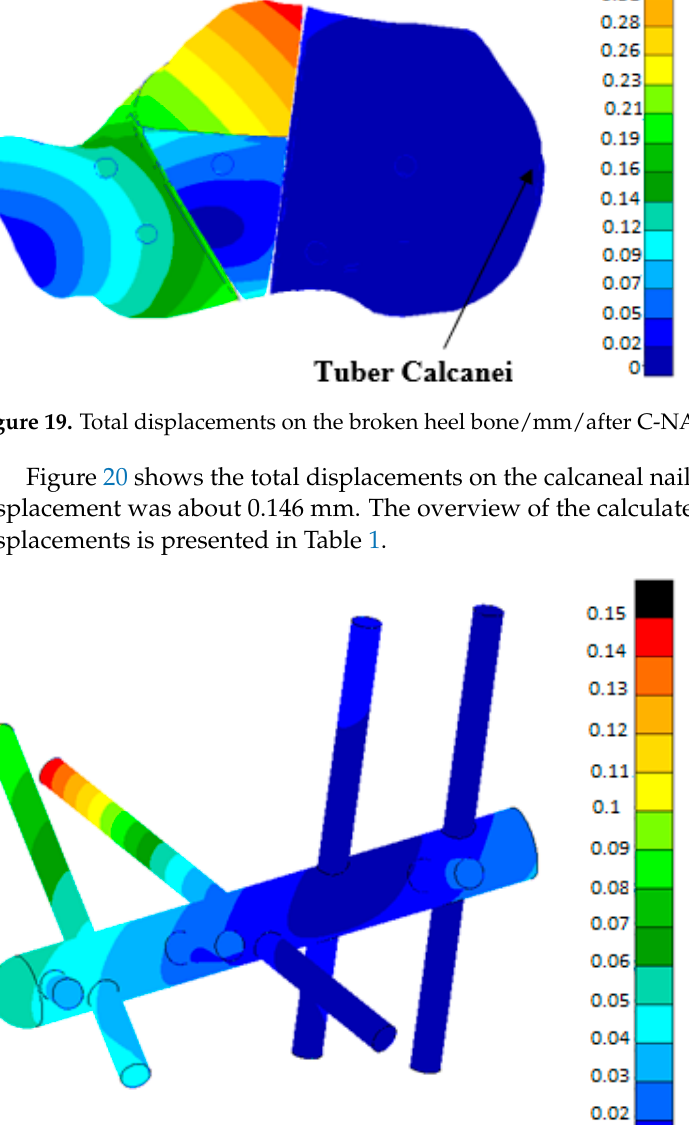
Figure 18. Distribution of the reduced stress on the fractured heel bone containing C-NAIL accord- ing to the HMH theory/MPa/.